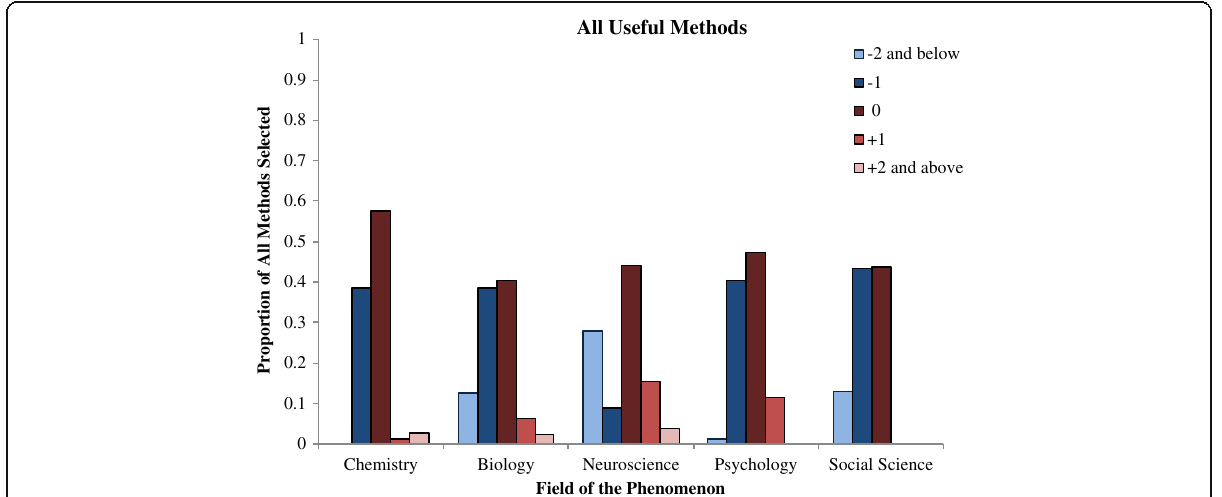
Fig. 1 Proportion of times each level method was selected on the all useful methods question, broken down by the field of the